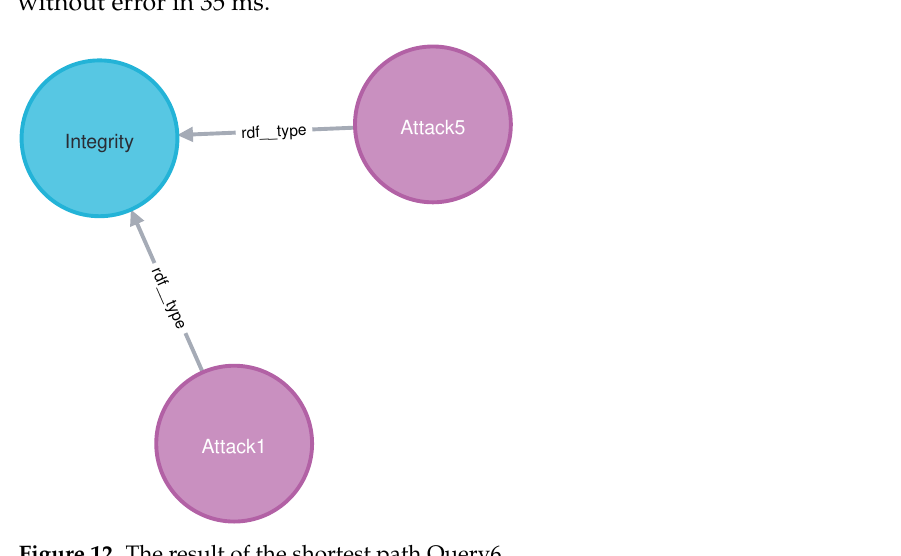
Figure 12. The result of the shortest path Query6.